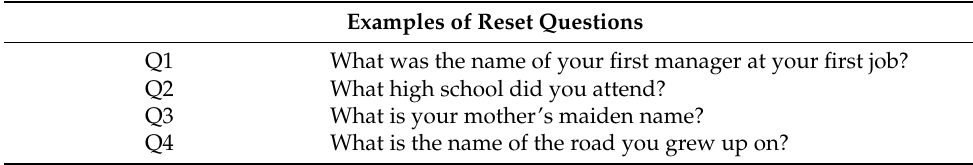
Table 1. Example of standard password reset questions.